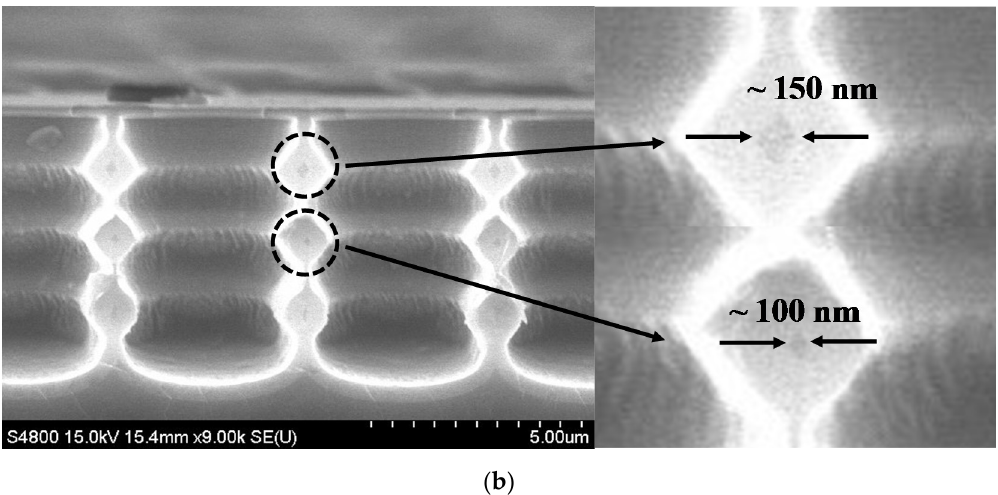
Figure 5. Fabrication of vertically-stacked silicon-nanowire array. ( a ) Cross-sectional view (oxidation for exact time); ( b ) cross-sectional view (excessive wet-oxidation case).